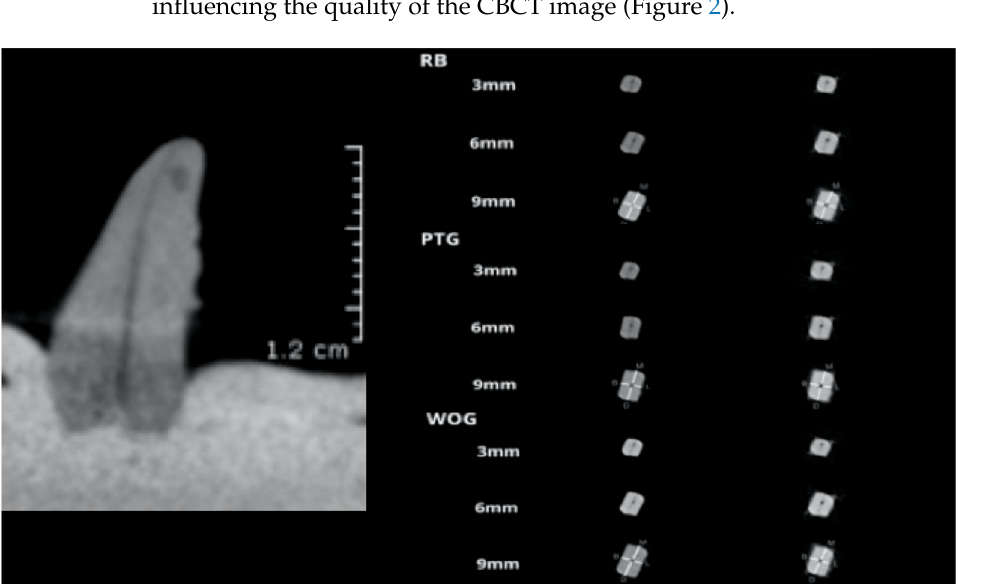
Figure 2. CBCT image of a printed dental replica with a simulated curved root canal, and RB (Reciproc Blue) PTG (ProTaper Gold) and WOG (WaveOne Gold) pre- and post-instrumentation aspects at different levels.